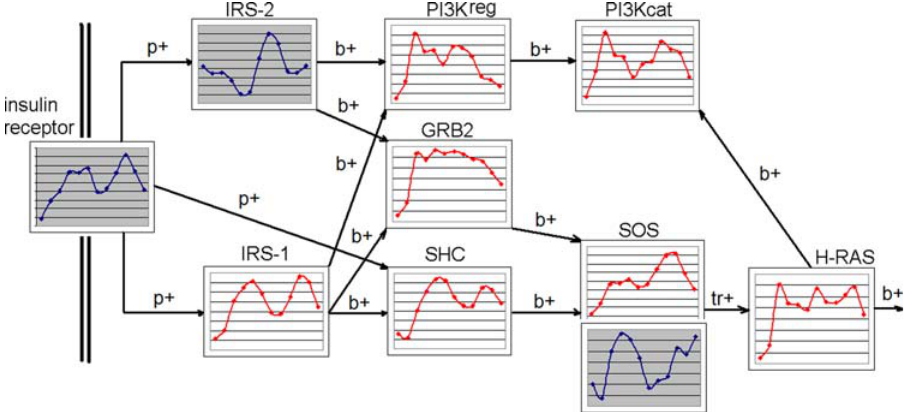
Figure 3. Insulin regulation of lipid metabolism in white adipose tissue (fragment). Transcripts called present are plotted with a red line on a white pane, absent transcripts are plotted blue on gray. Interactions are marked as p + (activation by phosphorylation), b + (activation by bonding) and tr + (transcription activation). Timing of insulin receptor substrate transcription (IRS-1) is perfectly synchronized with insulin receptor transcription rate in spite of the absence call for the